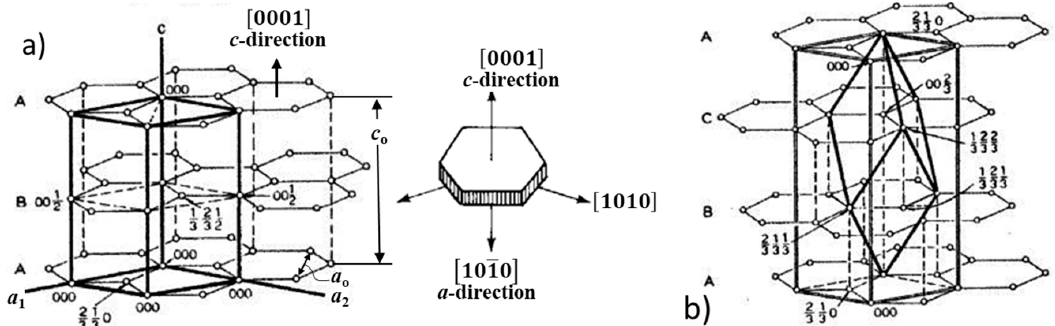
Figure 4. Crystal lattice of allotropes of graphite: ( a ) Hexagonal graphite; lattice parameters a o = 0.2462 nm, c o = 0.6708 nm; ( b ) rhombohedral system; lattice parameters: a o = 0.3635 nm, α = 39.49°; hexagonal system lattice parameters: a o = 0.2462 nm, c o = 1.0062 nm; adapted after [18].